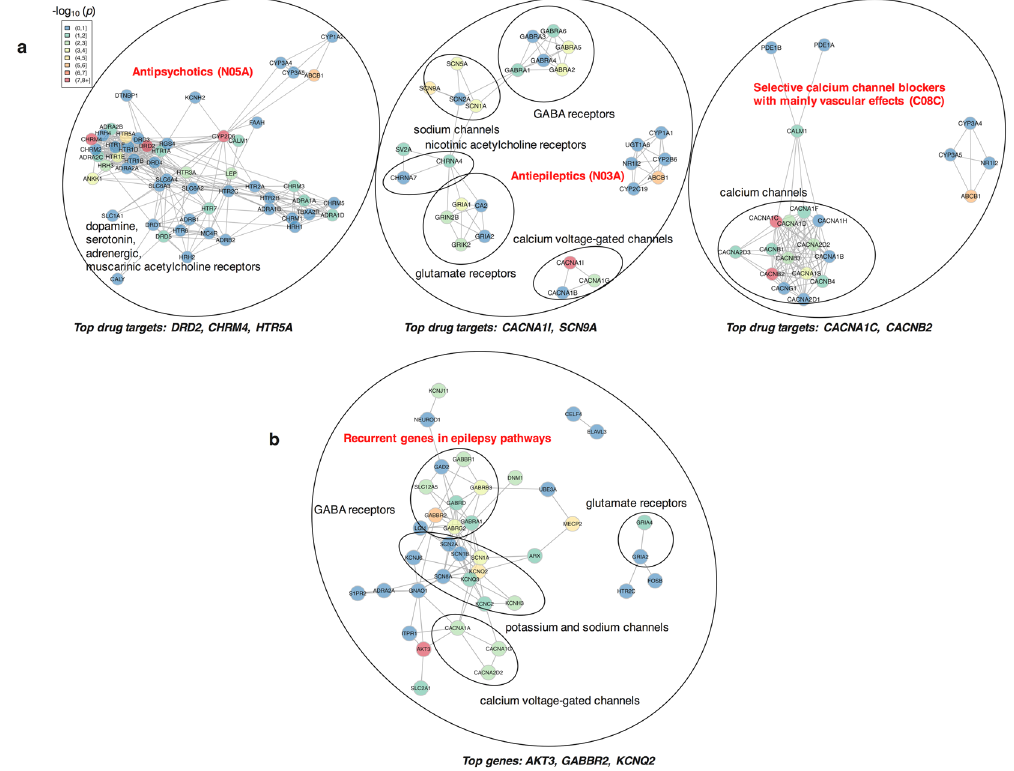
Figure 4. Protein-protein interaction networks. The interactions and interaction scores were obtained through the STRING 17 online platform. Vertices were placed on a plane using the Fruchterman-Reingold layout algorithm. Each node is colored by − log 10 (p), which measures the degree of association of a gene with schizophrenia (SCZ-PGC2). (a) Protein-protein interaction networks for the three drug classes significant in SCZ-PGC2: only proteins targeted by at least 2 drugs within the class are shown. (b) Protein-protein interaction network in epilepsy pathways: only genes present in at least 10 epilepsy pathways from Open Targets are